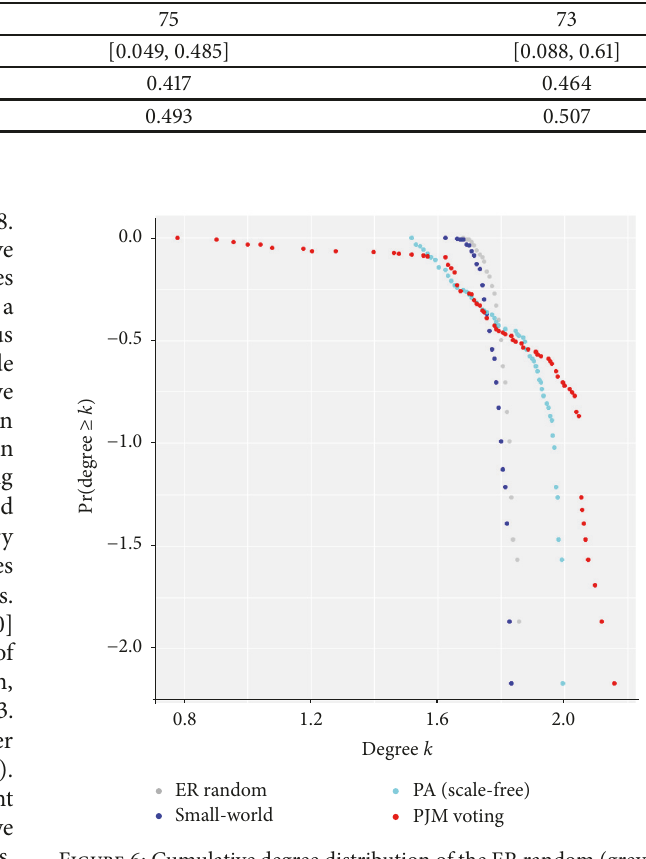
Figure 6: Cumulative degree distribution of the ER random (grey), the small-world (blue), the scale-free (cyan), and the PJM voting (red)